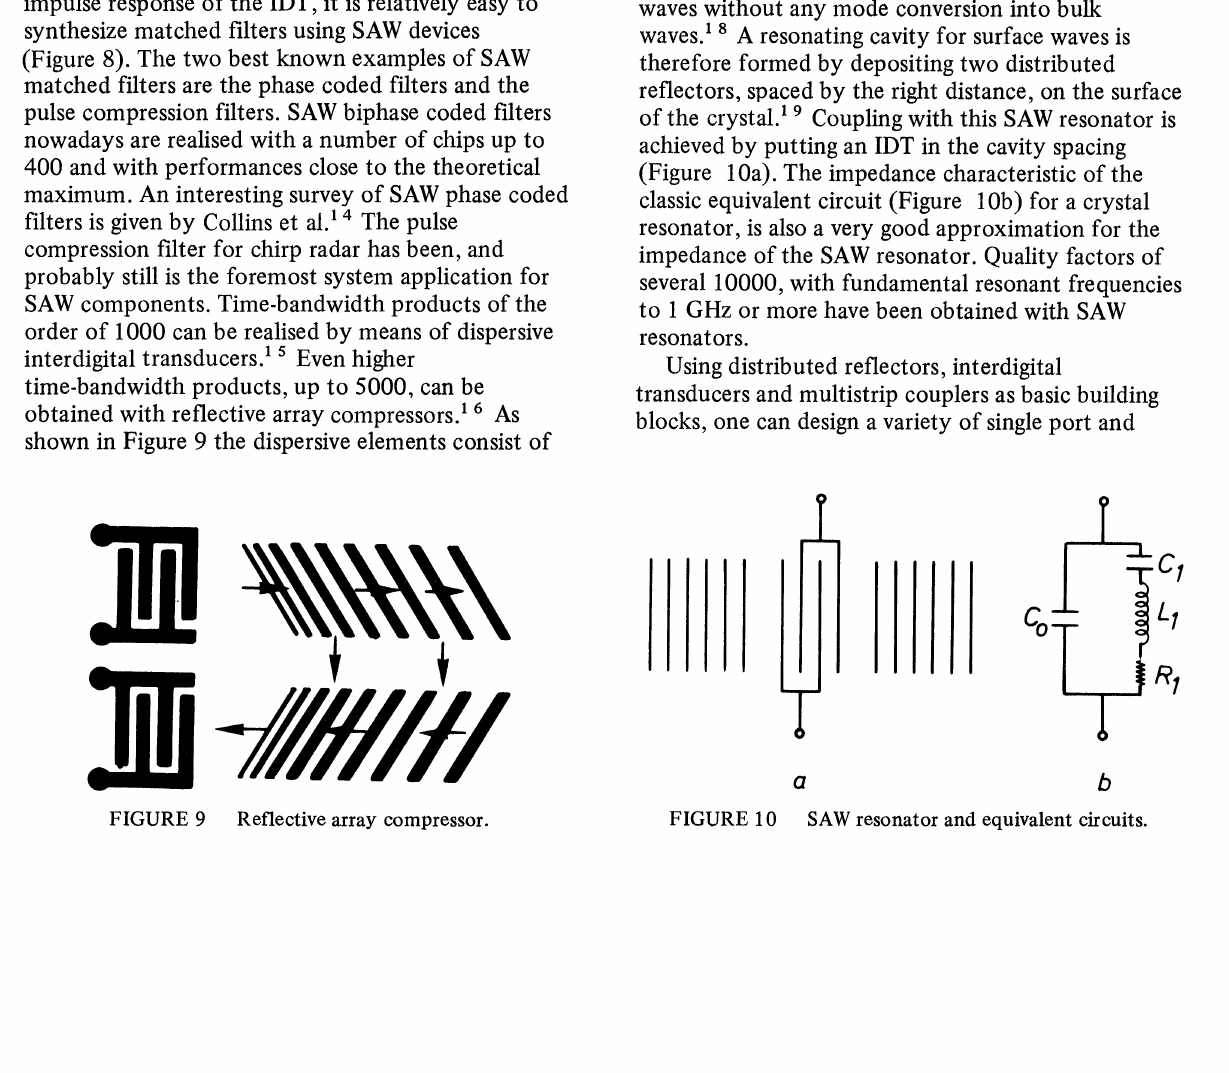
FIGURE 9 Reflective array compressor.